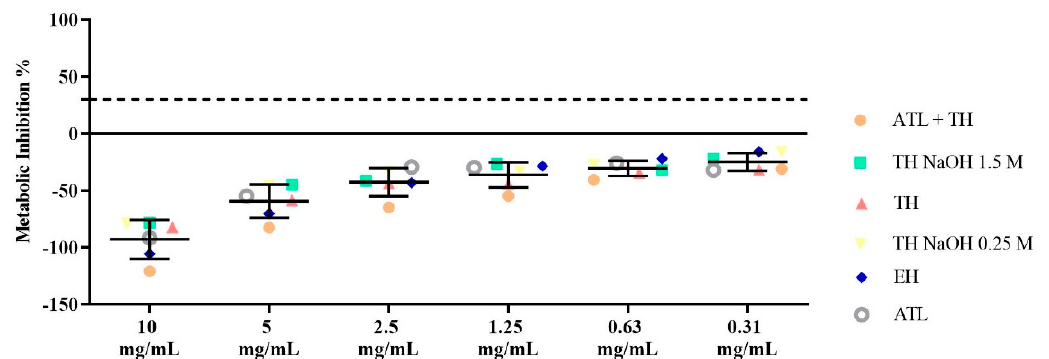
Figure 5. Results of the metabolic inhibition in % for the following concentrations: 10, 5, 2.5, 1.25, 0.63 and 0.31 mg/mL of the TH, TH NaOH 0.25 M, TH NaOH 1.5 M, ATL, ATL + TH and EH mannans extracts.